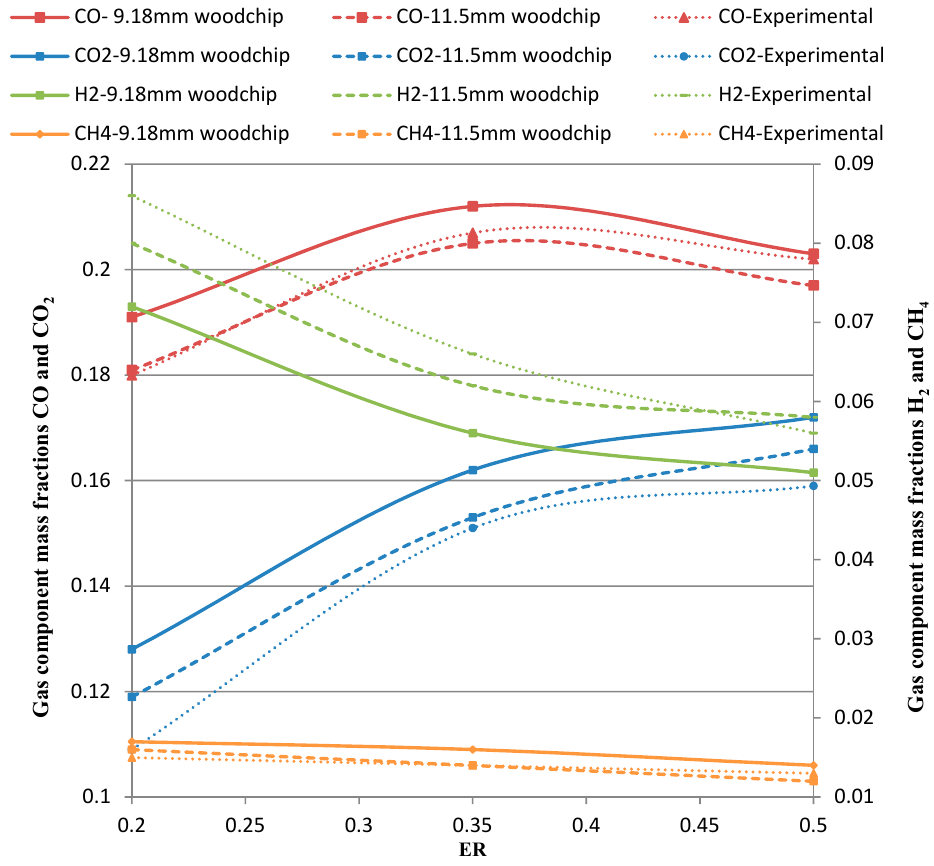
Figure 6 . Variation of gas component mass fractions as a function of ER. Figure 6. Variation of gas component mass fractions as a function of